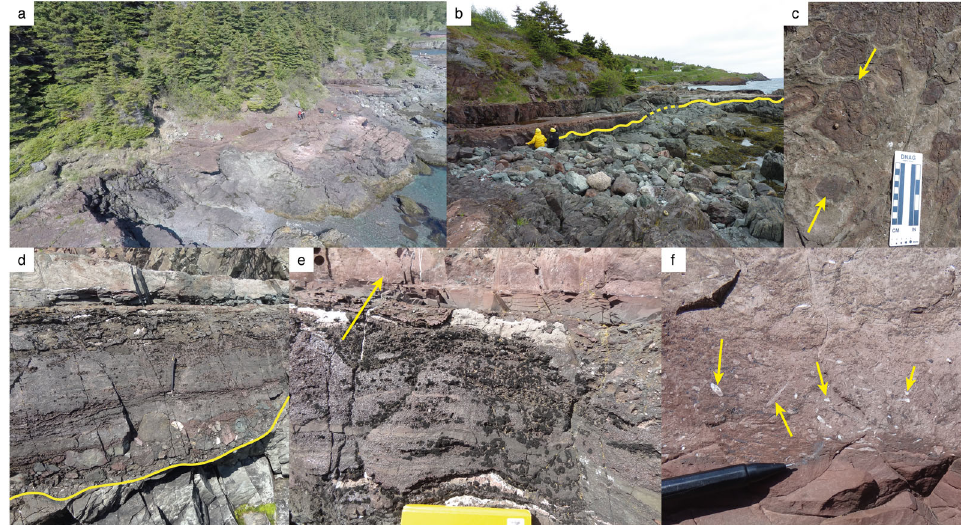
Fig. 6 Fossil site at Bacon Cove. Yellow line in b and d marks the P Є / Є boundary. a Aerial view from NE. Geologists for scale. b Outcrop overview. Geologists for scale. c Surface of Bonavista Formation hosting abundant oncoids and microbialites (arrows). d Contact between uppermost Ediacaran (Drook Formation) and lowermost Cambrian strata (Bonavista Formation) in Bacon Cove. e Section, c. 160 – 200 cm (Bonavista Formation) with arrow marking the coquina layer. f Coquina containing the fossil material described here. Arrows mark calcareous shells; view perpendicular to bedding.